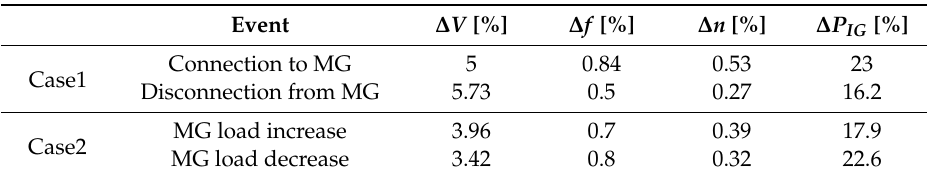
Table 1. Parameters